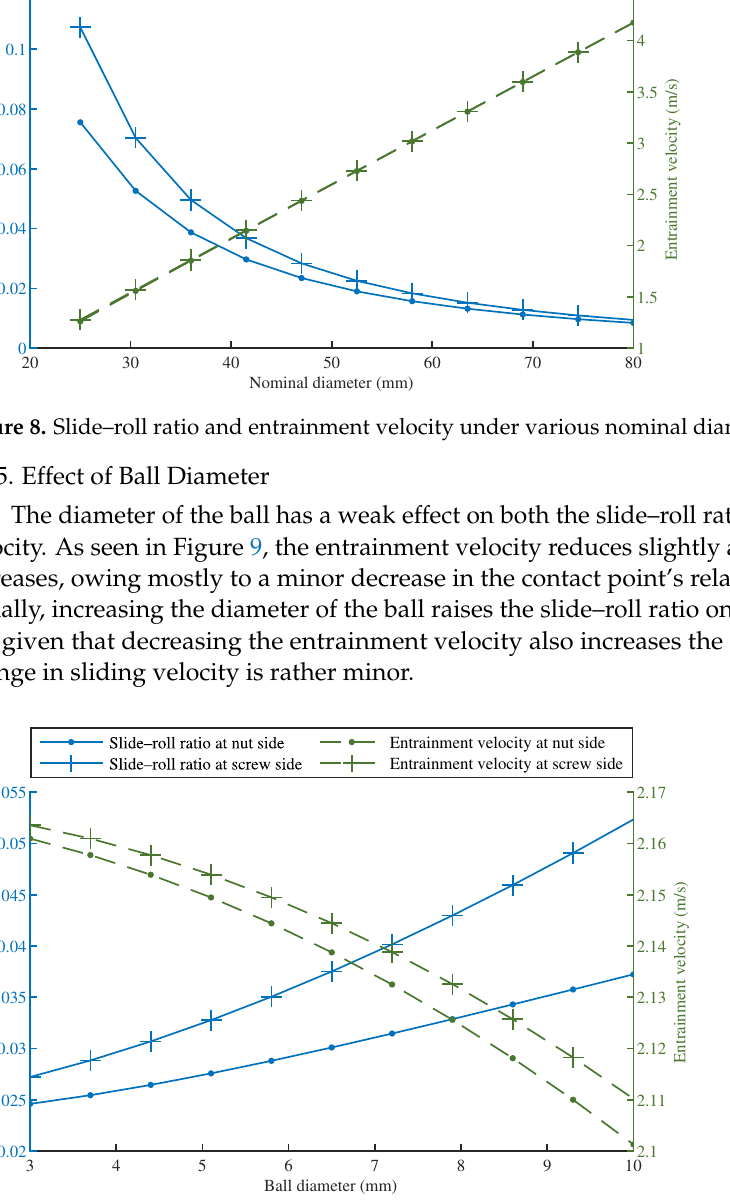
Figure 9. Slide–roll ratio and entrainment velocity under various ball